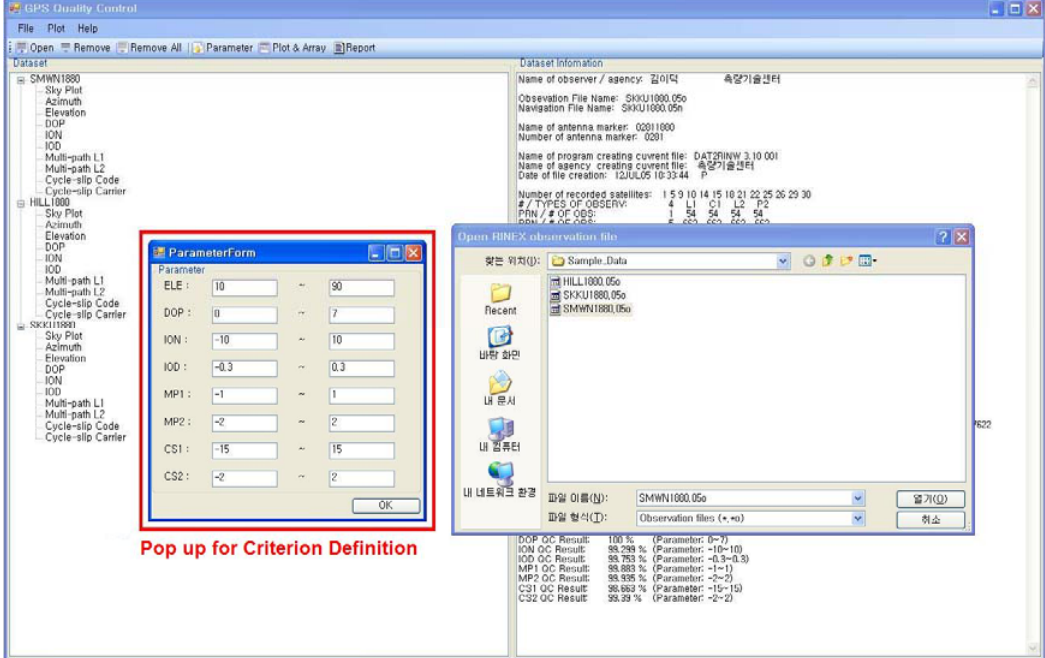
Figure 2. Screen shot of interactive start window of GPSQC program.